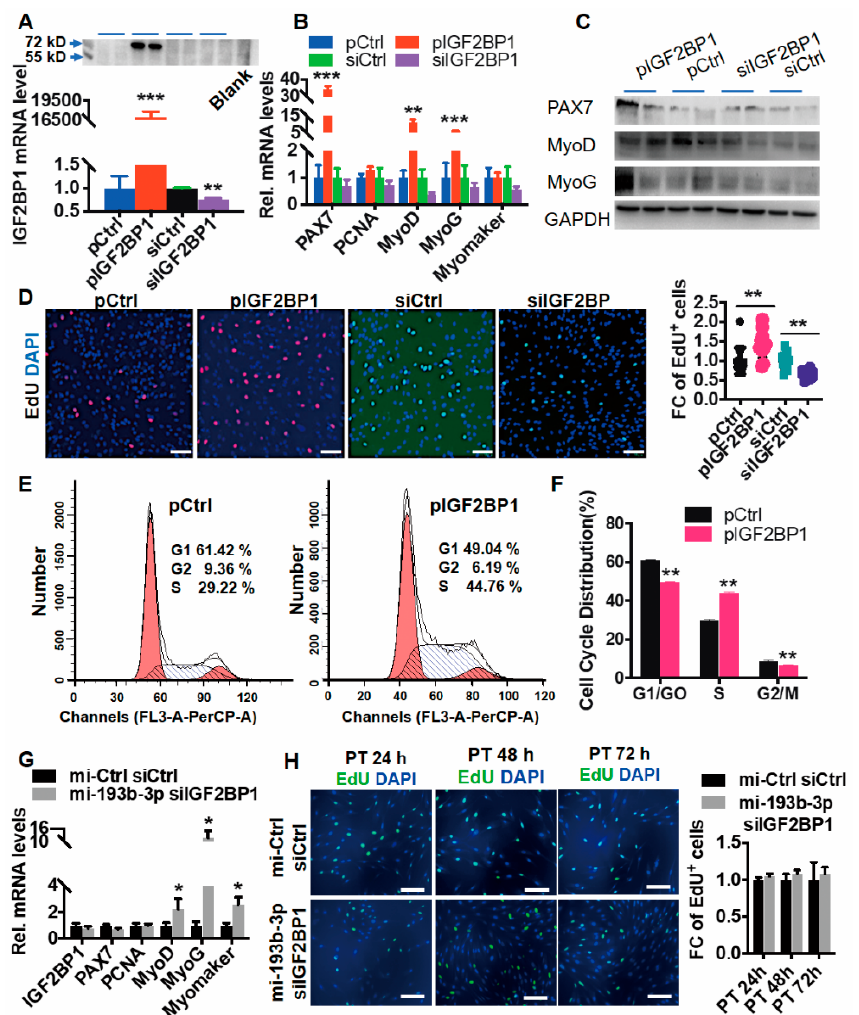
their mRNA abundance (Figure 4C), and EdU + cells were increased in pIGF2BP1 and de- creased in siIGF2BP1-treated cells, compared to the control group (Figure 4D). Moreover, we simply discriminated sub-cycling cells using flow cytometric analysis. The pIGF2BP1 treatment upregulated S-phase cells but downregulated G1/G0 cells (Figure 4D). These results phenocopy overexpression or deficiency of the miR-193b phenotype, respectively.